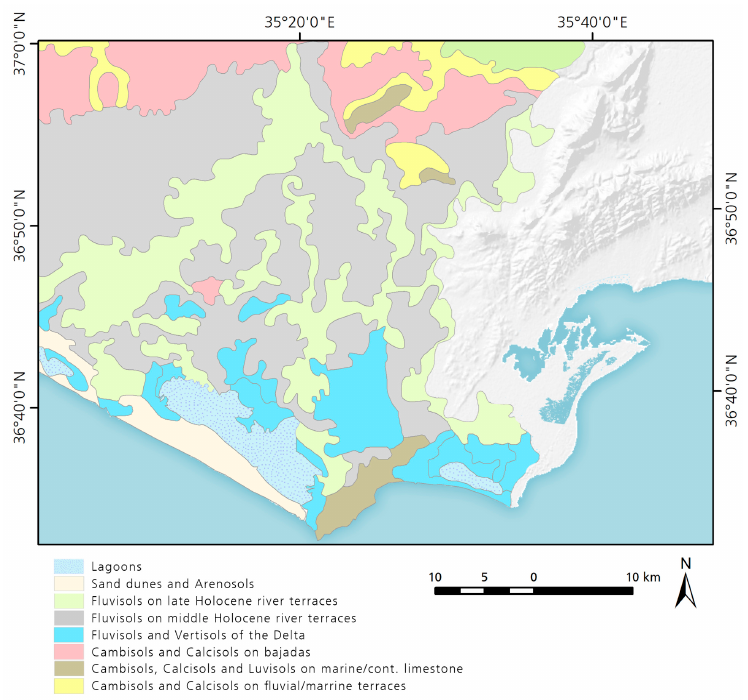
Figure 13. Soil map of Çukurova (data collection [62]), © Susanne Rutishauser.